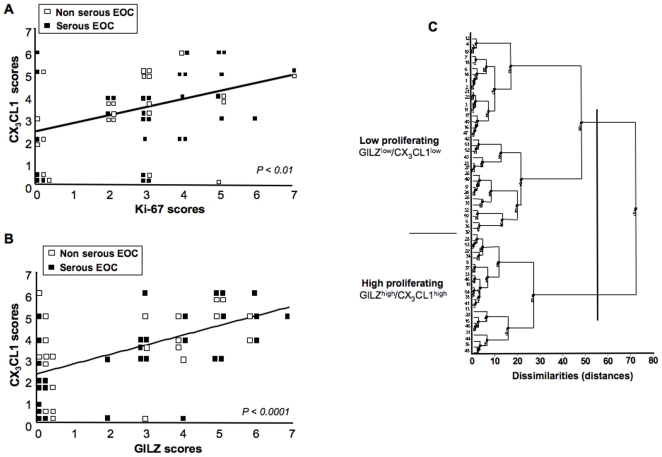
Correlation of CX3CL1 and Ki-67 and GILZ in EOC.(A and B) CX3CL1 and Ki-67 final scores (A, Spearman test, P<0.01, r = 0.38) and CX3CL1 and GILZ final scores (B, Spearman test, P<0.0001, r = 0.59) were positively correlated in 54 EOC specimens including serous (black squares) and non serous (white squares) samples. (C) Dendrogram generated by hierarchical agglomerative cluster analysis for the 54 EOC specimens studied, against age at diagnosis, FIGO stage, grade, Ki-67, GILZ, CX3CL1 and CXCL12 immunoreactivity levels. Two clusters are identified, with low (top) and high (bottom) levels of proliferation. Relevant specimens are labeled with numbers.